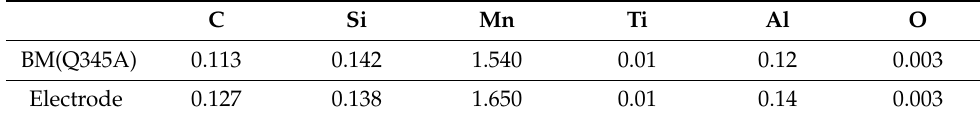
Table 3. Measured chemical compositions of BM and electrode (wt